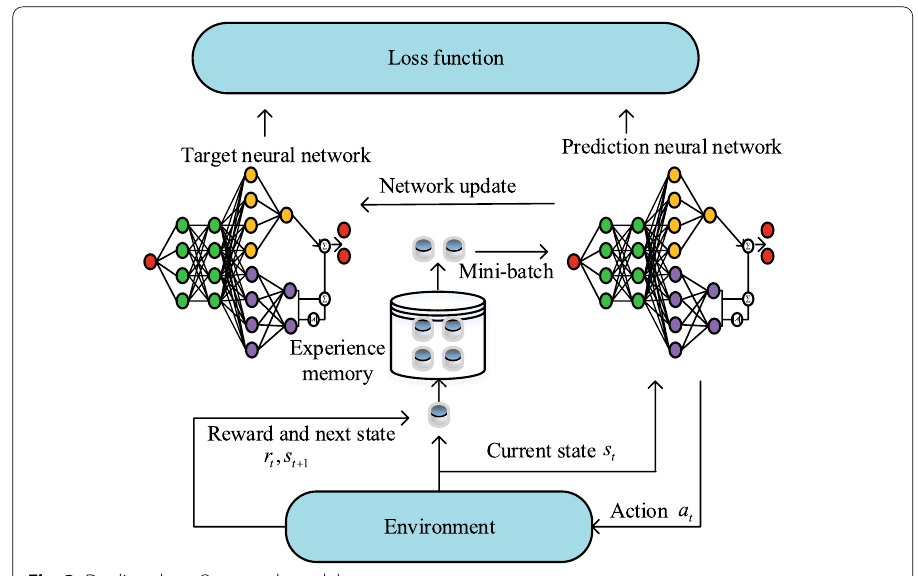
Fig. 3 Dueling deep Q-network